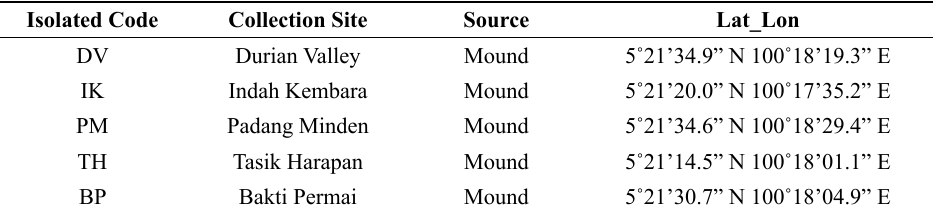
Fig 1 . Map of the USM main campus, Penang showing the sites of G. sulphureus populations being collected. The abbreviation details are listed in Table 1. The map was edited and retrieved from Meng et al., (2002). Table 1 . Collection sites, isolated code, source, and GPS coordinate of each G. sulphureus in this